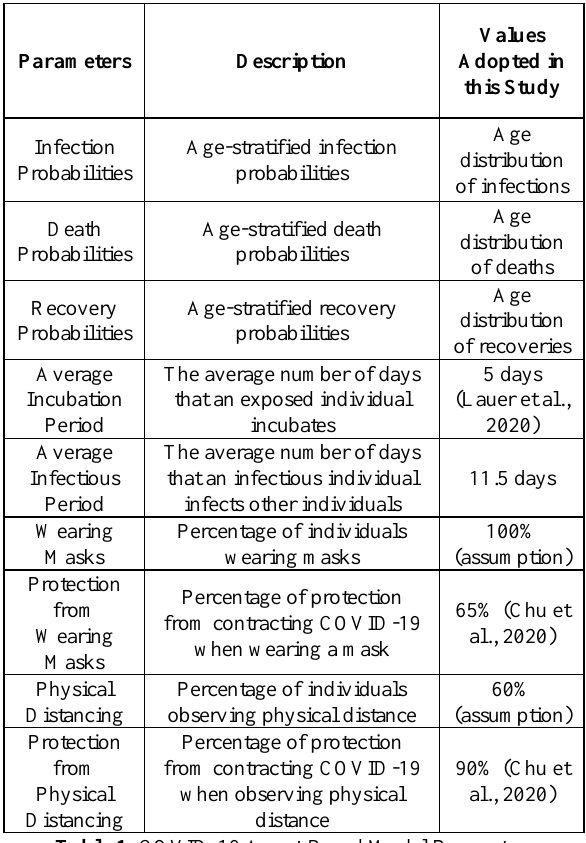
Table 1. COVID-19 Agent-Based Model